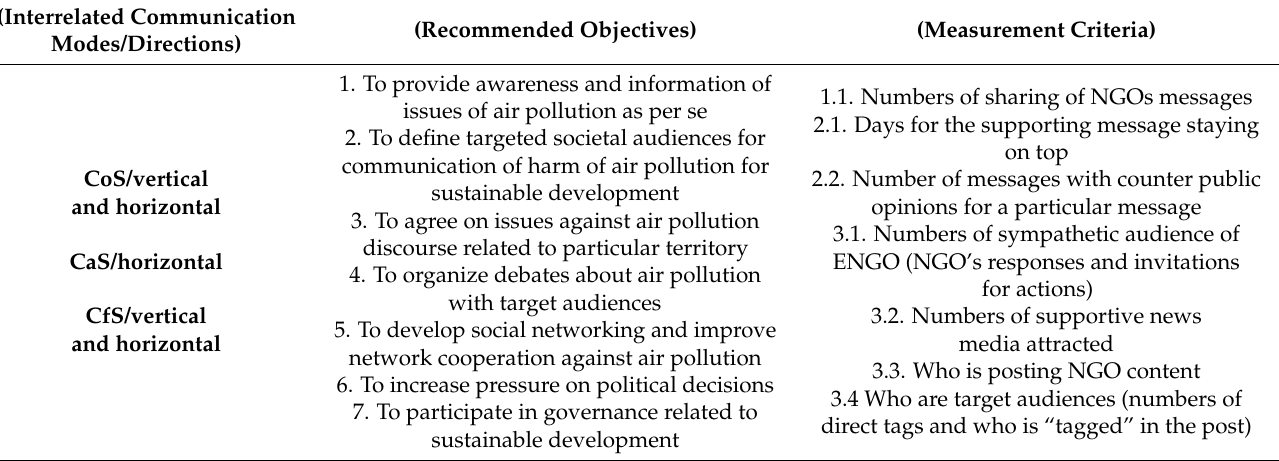
Table 3. E-communication management against air